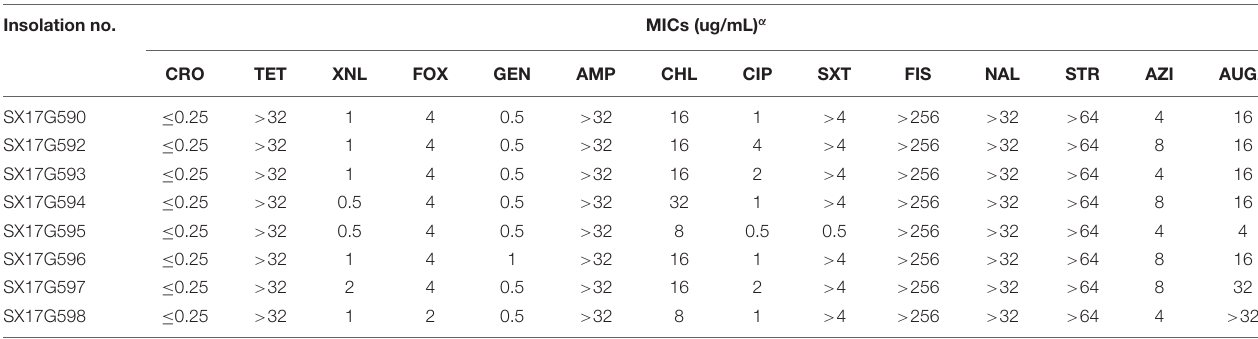
TABLE 1 | MIC results of 14 antibiotics for 8 outbreak S . Typhimurium strains. Insolation